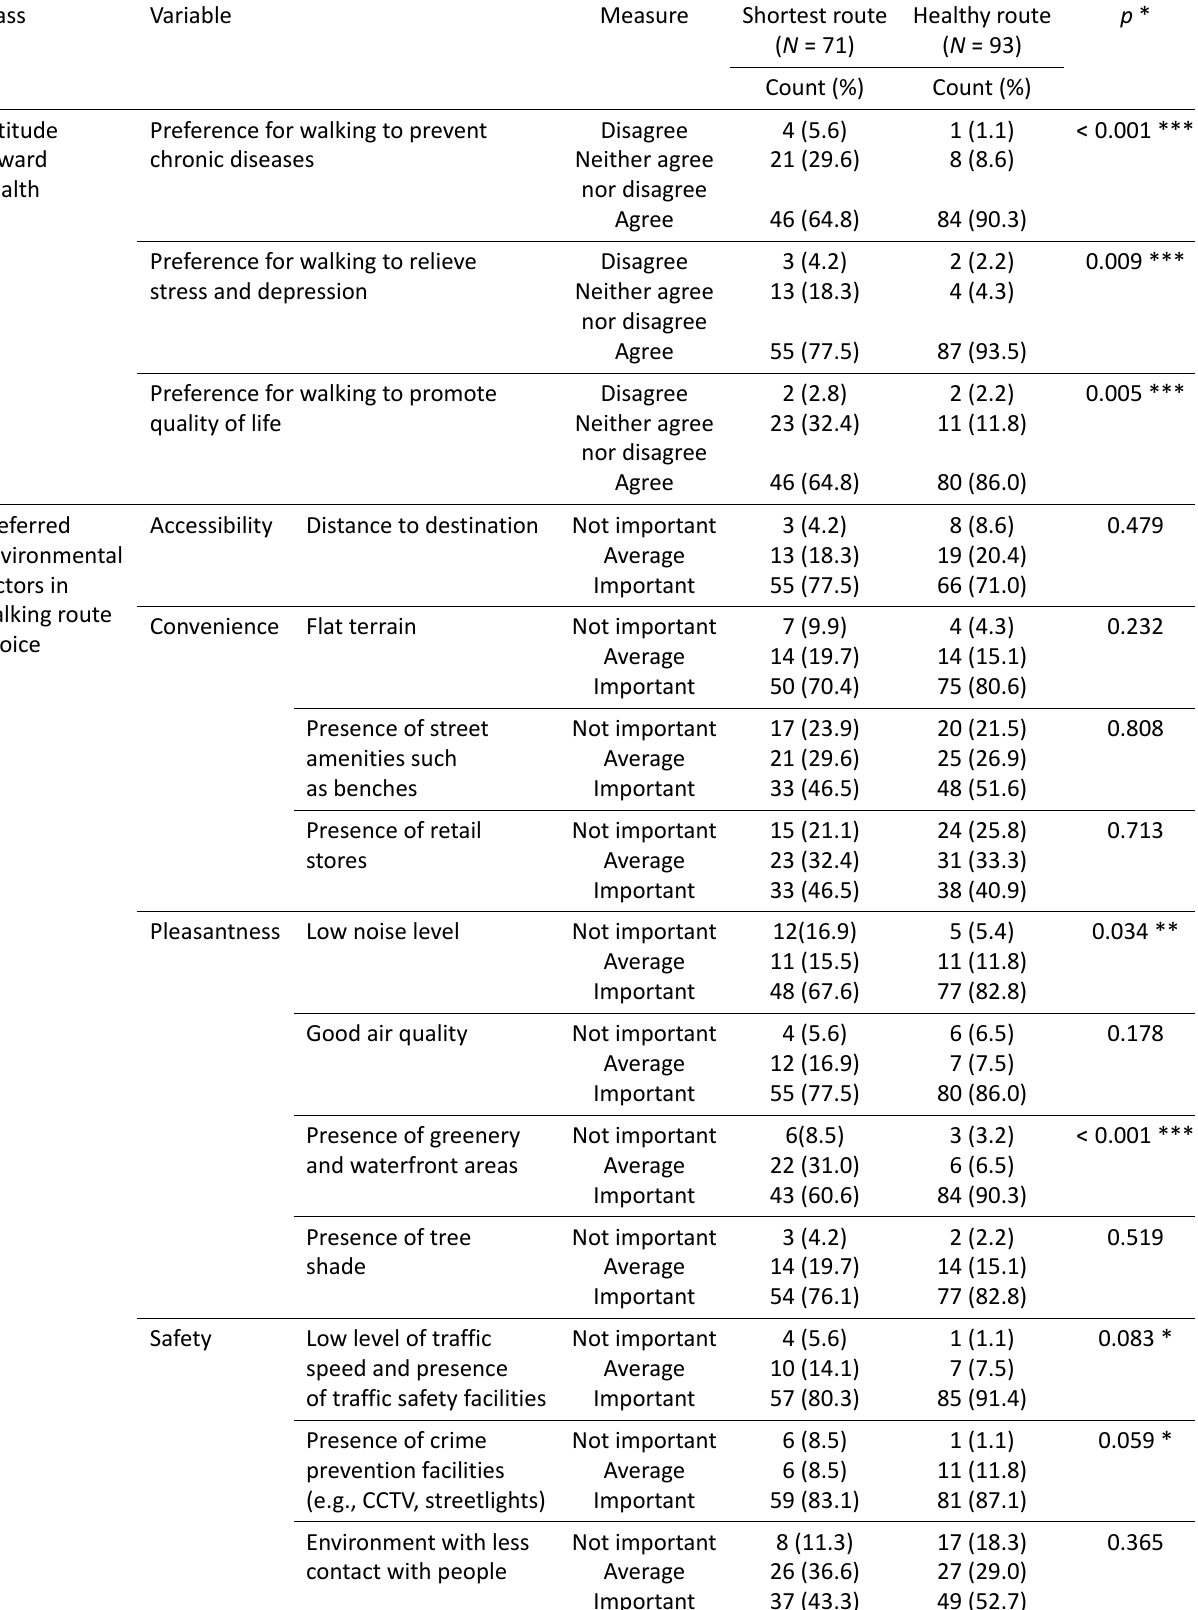
Table 1. (Cont.) Comparison of individual characteristics and perceptions between healthy and the shortest route choices using t and chi‐square